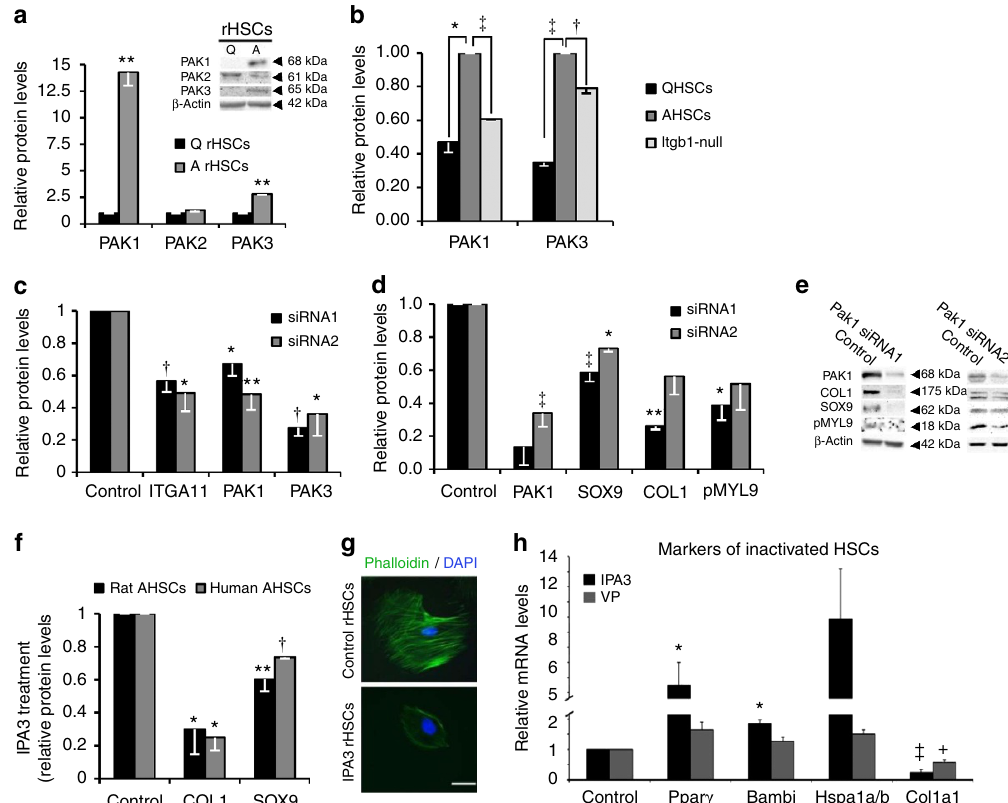
Figure 5 | Integrin beta-1 inactivation identifies PAK signalling as a requirement for liver fibrosis. ( a – f ) Quantification of immunoblots showing: ( a ) increased protein levels of PAK-1 and PAK-3 on activation of rat HSCs compared with quiescent (Q) cells; ( b ) decreases in both PAK-1 and PAK-3 following the loss of integrin beta-1 (‘ Itgb1 -null’) in activated mouse HSCs (AHSCs). Levels in mouse QHSCs are shown for comparison. ( c ) Expression of PAK-1 and PAK-3 proteins are similarly diminished following Itga11 knockdown using two independent siRNAs in activated mouse HSCs relative to control (scrambled siRNA). ( d , e ) Decreases in the levels of activated HSC markers, SOX9, COL1 and phosphoMyl9 (PMYL9) following PAK-1 abrogation by siRNA1 in activated rat HSCs relative to their respective scrambled control levels (‘Control’). Similar decreases were observed with a second independent siRNA (siRNA2). Representative immunoblot is shown in e . ( f ) Decreases in COL1 and SOX9 following the inhibition of group I PAKs using IPA3 treatment in rat and human- activated HSCs compared with DMSO control. ( g ) IPA3 treatment of activated rat HSCs disrupts the actin cytoskeleton (phalloidin staining in green). Note, the rounded cell appearance following IPA3 treatment similar to Fig. 3e and Supplementary Fig. 1f. Scale bar, 50 m m. ( h ) Relative expression levels by qRT– PCR following VP or IPA3 treatment of activate rat HSCs for three genes identified as markers of HSC inactivation 4 . As expected, Col1a1 levels were decreased in response to both treatments. For experiments in a – h , n ¼ 3 or 4. Two-tailed unpaired t -test was used for statistical analysis. Data are shown as means ± s.e.m. * P o 0.05, ** P r 0.01, w P o 0.005, z P r